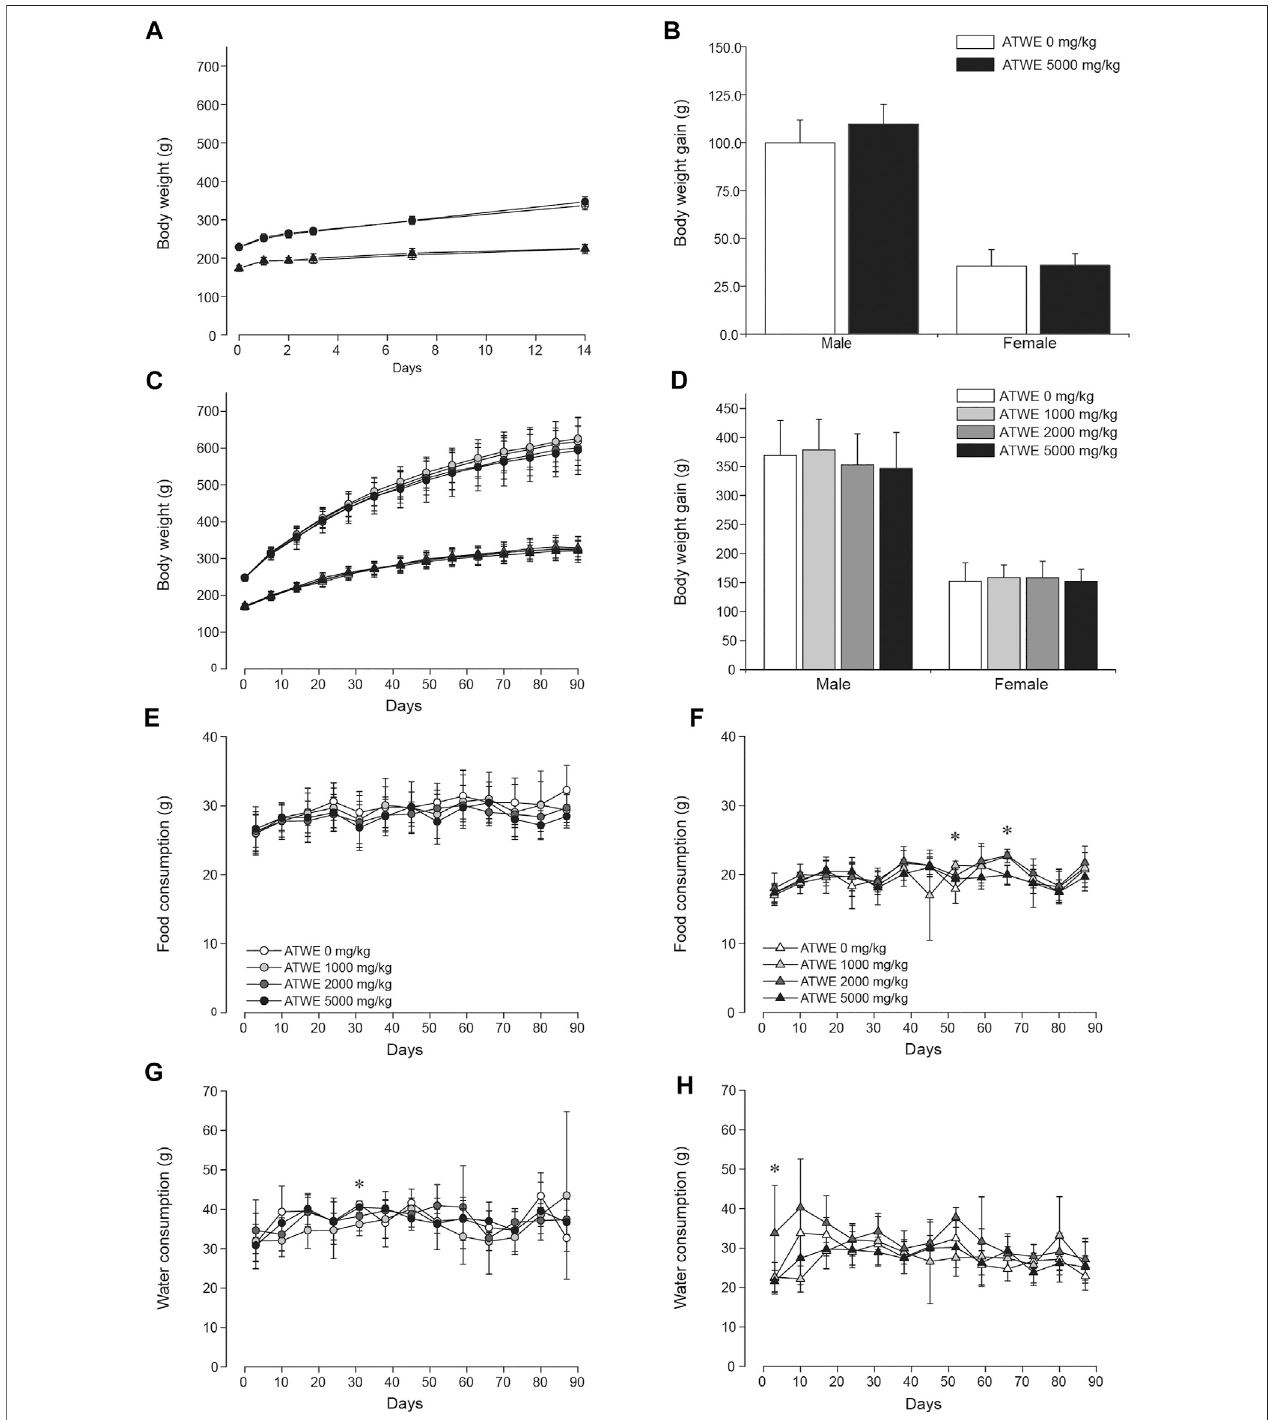
FIGURE 3 | Acer tegmentosum Maxim. water extract did not affect body weight gain and dietary patterns in SD rats. Male and female animals were orally administered either 0 or 5,000 mg/kg BW Acer tegmentosum Maxim. water extract (ATWE) once and monitored for 14 days in the acute toxicity study (n (cid:2) 5/gender/ group) or one of 0, 1,000, 2,000, and 5,000 mg/kg BW for 90 days in the repeated toxicity study (n (cid:2) 10/gender/group). In the acute toxicity study, ATWE-treated animals showed a comparable increase of (A) body weight for 14 days and (B) body weight grain measured at the end of the study to their respective control groups. Similarly, there was no difference in (C) body weight and (D) body weight gain between the control and AWTE-treated animalsregardless oftreated doses. The food and water consumption in male (E, G) and female (F, H) animals was not altered in the test substance – administered groups compared to the control groups. Circles, male; triangle, female; black symbols, 5,000 mg/kg; dark gray symbols, 2,000 mg/kg; light gray symbols, 1,000 mg/kg; and white symbols, 0 mg/kg ATWE. *; p < 0.05 by one-way ANOVA followed by post hoc Dunnett ’ s t-test.